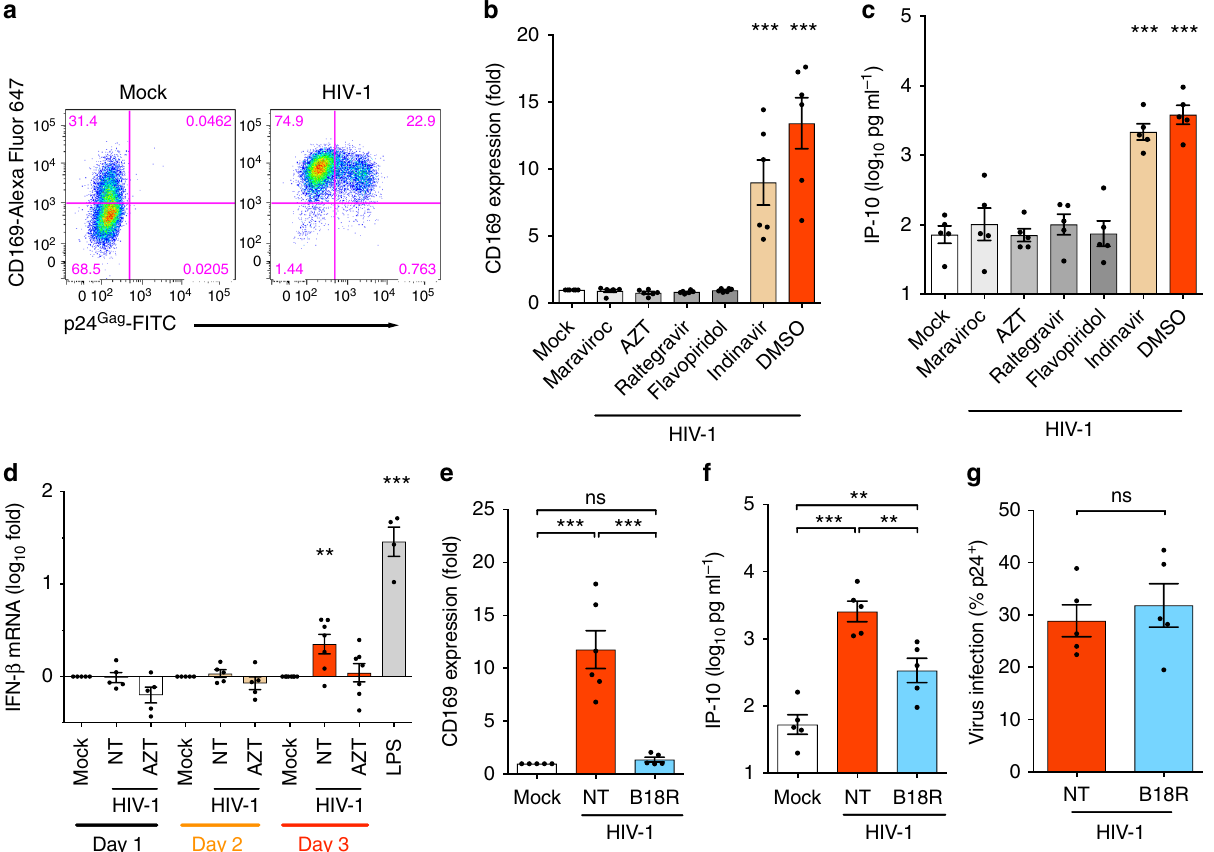
Fig. 1 Late step of HIV-1 replication in macrophages triggers immune activation. a Flow cytometry pro fi les (CD169 expression and intracellular p24 Gag ) of MDMs 6 days post infection with replication competent HIV-1 at MOI of 1. b , c Effects of HIV-1 inhibitors on CD169 expression ( b ) and IP-10 production ( c ) in MDMs. MDMs were treated with drugs prior to infection (maraviroc, AZT or raltegravir) or post infection ( fl avopiridol and indinavir) with replication competent HIV-1 as described in a . d Temporal expression of IFN- β mRNA in MDMs. MDMs were infected with a single-round HIV-1 (Lai Δ envGFP/G) at MOI of 2 and cells were harvested on day 1, 2, and 3 post infection for mRNA extraction. e – g Effect of B18R on CD169 expression ( e ), IP-10 production ( f ), and HIV-1 infection ( g ) in MDMs. MDMs were infected with replication competent HIV-1 as in a and analyzed 6 days post infection. NT: untreated. The means ± SEM are shown and each symbol represents an independent experiment. Two-tailed p -values: one-way ANOVA followed by the Tukey-Kramer post-test ( e , f ) or the Dunnett ’ s post-test ( b , c , and d ) or paired t -test ( g ), * p < 0.05, ** p < 0.01, *** p < 0.001, ns: not signi fi